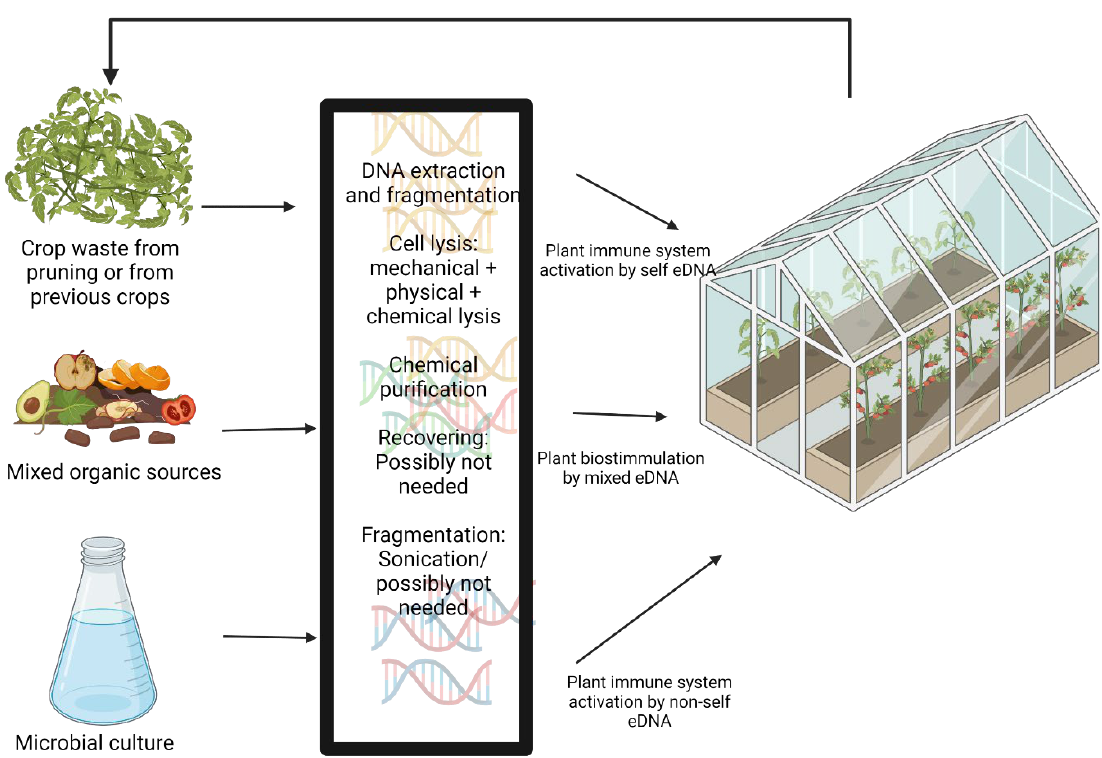
Figure 1. A proposed system of eDNA as an agriculture treatment with circular economy agricultural eDNA treatments. This figure was created using BioRender (https://biorender.com/, (accessed on 12 July 2021)).